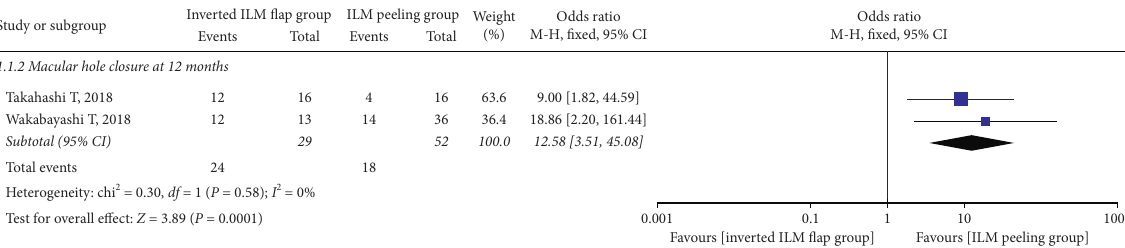
Figure 3: Forest plot comparing macular hole closure rate between inverted ILM flap and ILM peeling groups at 12 months after surgery. ILM � internal limiting membrane.